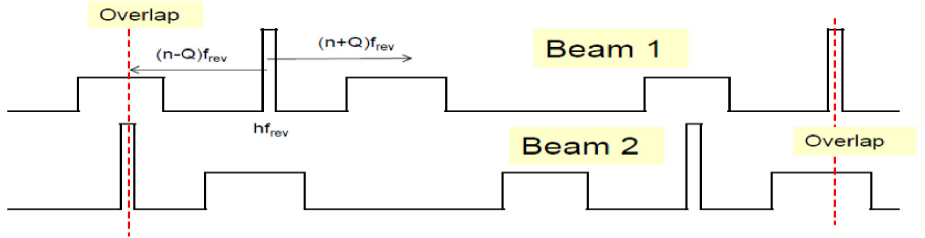
FIG. 15. Transverse frequency overlap.